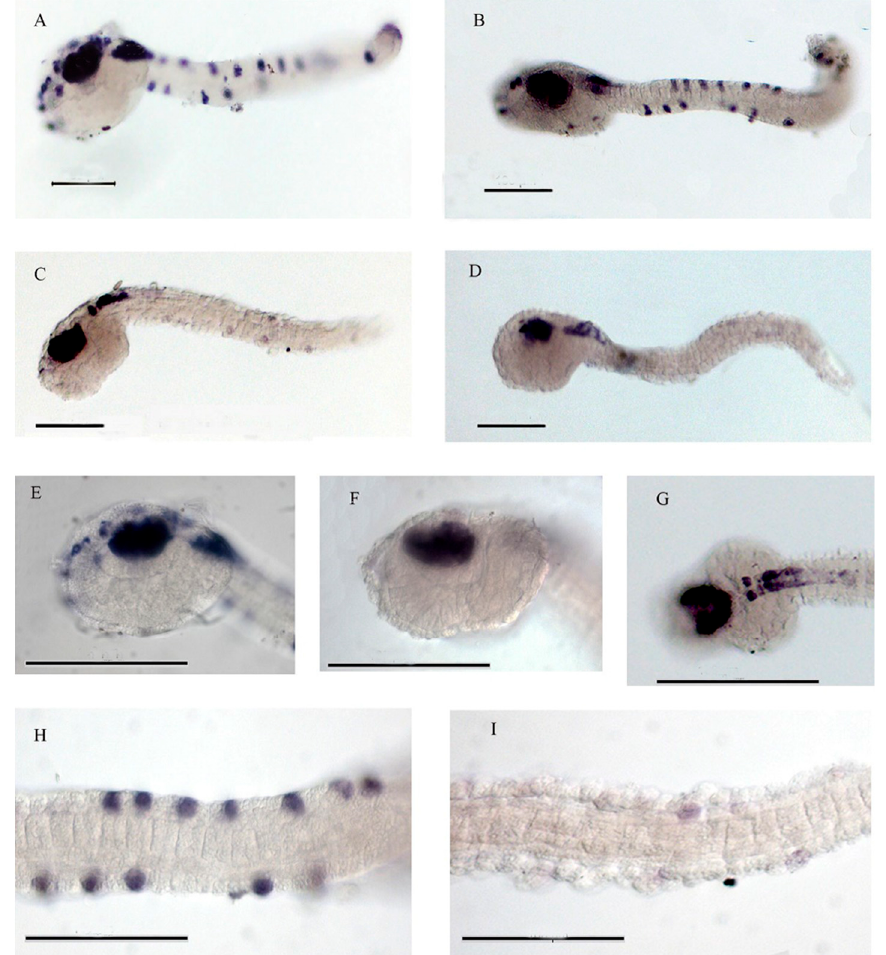
Figure 3. Whole-mount in situ hybridization with Ci-Pans probe. ( A ) Control and ( B ) PNA-sc9-injected embryos reveal similar expression. ( C , D ) Two lateral views of PNA-a9-injected embryos displaying a marked decrease of the signal in the epidermal sensory neurons. At higher magnification, the decrease of the signal in peripheral neurons induced by PNA-a9 is particularly evident in the trunk (( E ) control; ( F , G ) injected samples) and tail (( H ) control; ( I ) injected embryo). Scale bar, 100 µ m for all